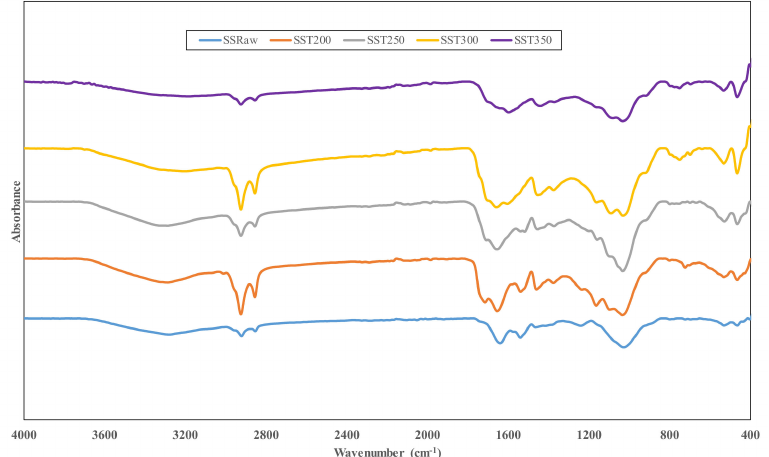
Figure 3. FTIR spectra of raw and torrefied sewage sludge at varying temperature.